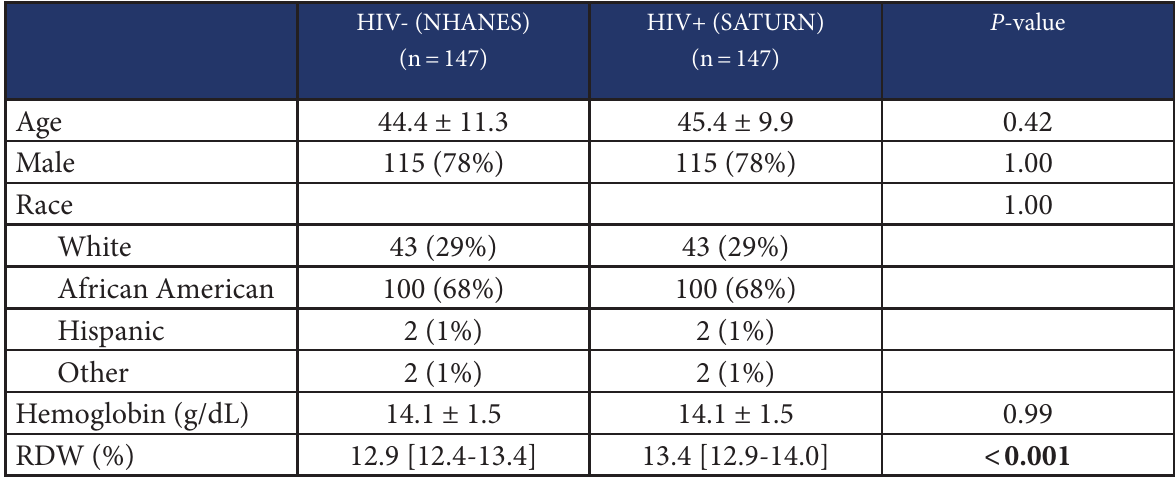
Table 2. Comparison between HIV-infected and matched HIV-uninfected patients.